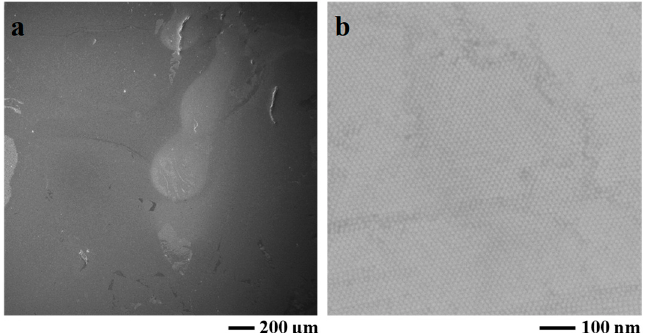
Figure 5. ( a ) SEM and ( b ) high-resolution SEM images of 9.7 nm Au NPs film. The process of the synthesis and self-assembly of Au NPs is shown in Scheme 1.